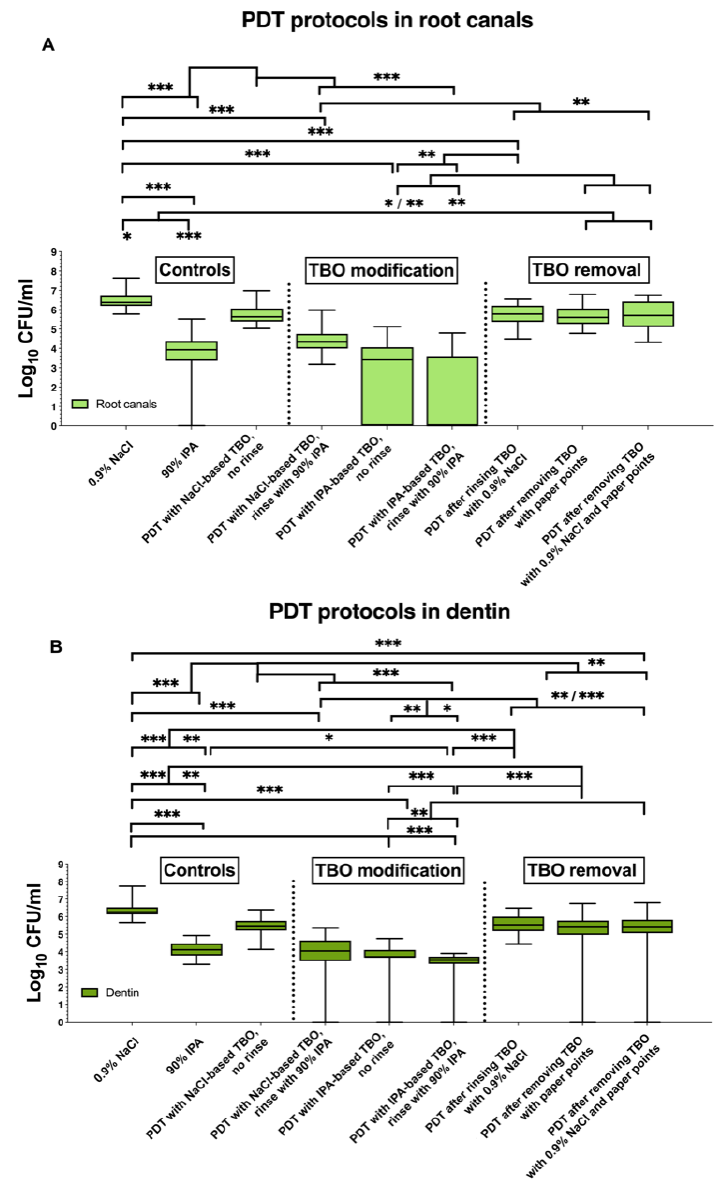
Figure 1. Boxplots of colony-forming units (CFU) counts, demonstrating the antimicrobial effect of PACT on E. faecalis after 72 h-incubation in root canals of extracted teeth ( n = 270). After antimicrobial treatment, root canals were sampled using ( A ) sterile paper points and ( B ) collecting dentin chips. Toluidine blue (TBO, 16 µg/mL) served as the photosensitizer, activated by a 100-mW LED light source. The following treatment groups were tested: irrigation using 0.9% NaCl (negative control) or 90% isopropanol (IPA; positive control), conventional photoactivated chemotherapy (PACT) with NaCl-based TBO and no final rinse (standard control), PACT with NaCl-based TBO and final rinse with 90% IPA, PACT with IPA-based TBO and no final rinse, PACT with IPA-based TBO and final rinse with 90% IPA, PACT with removal of access photosensitizer using either 0.9% NaCl solution or sterile paper points or both. Box plots represent the CFUs determined by selective agar plating, while horizontal lines indicate their median values. Undetectable values were ascribed the lowest detection limit value of the assay to allow for log transformation. The CFUs are presented on a log 10 scale per mL (log 10 / mL). The p -values of the significantly di ff erent data are marked on the graphs (*, p ≤ 0.05; **, p ≤ 0.01; ***, p ≤